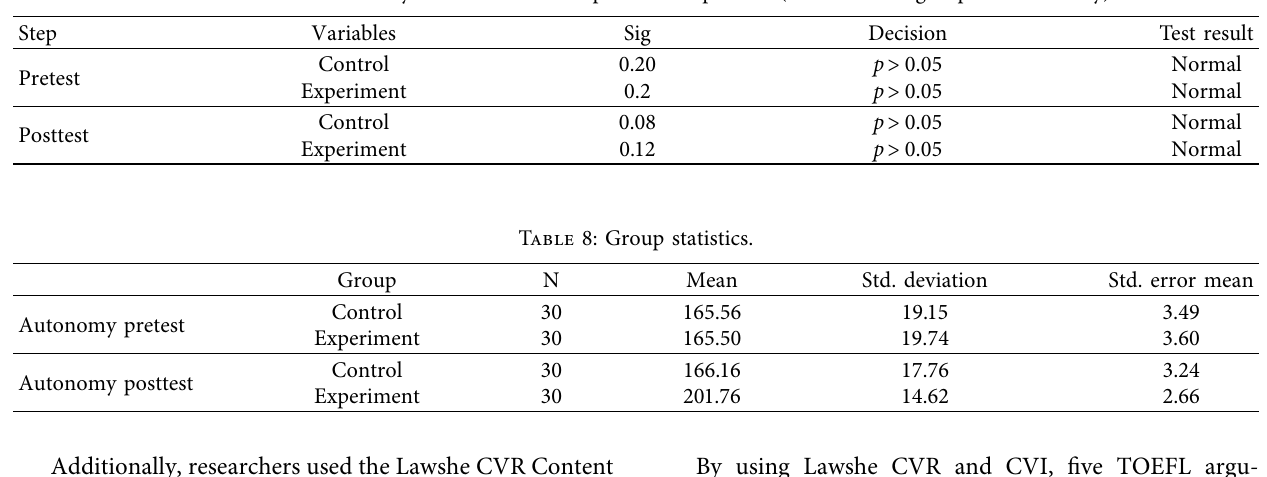
Table 7: Test the normality of variables in the pretest and posttest (the advanced group for autonomy).